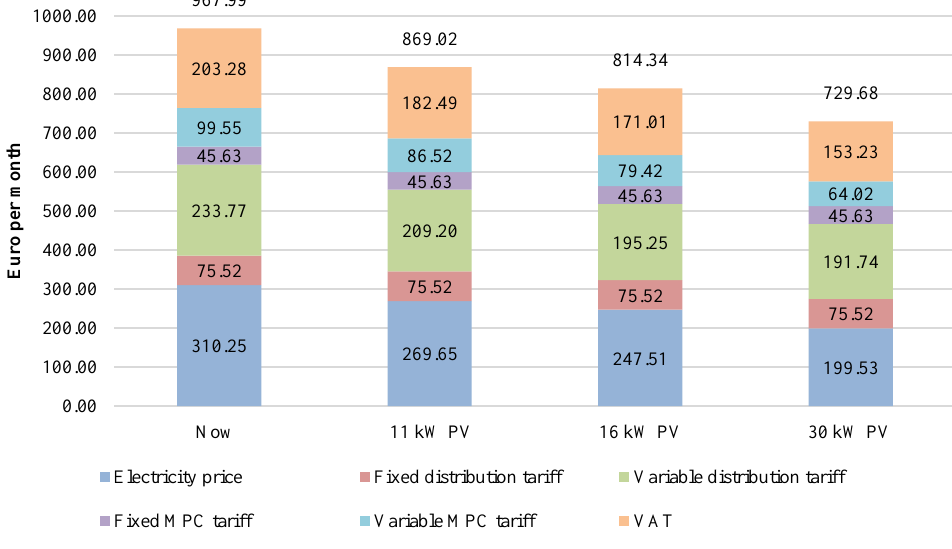
Fig. 2. The average monthly electricity bill before and after installation of solar panels. Capital costs of a PV system and its investment payback time is visualized in Fig. 3. The payback time for 16 kW PV is lower than both 11 kW and 30 kW systems but still, a payback time of almost 10 years is not a satisfactory result.